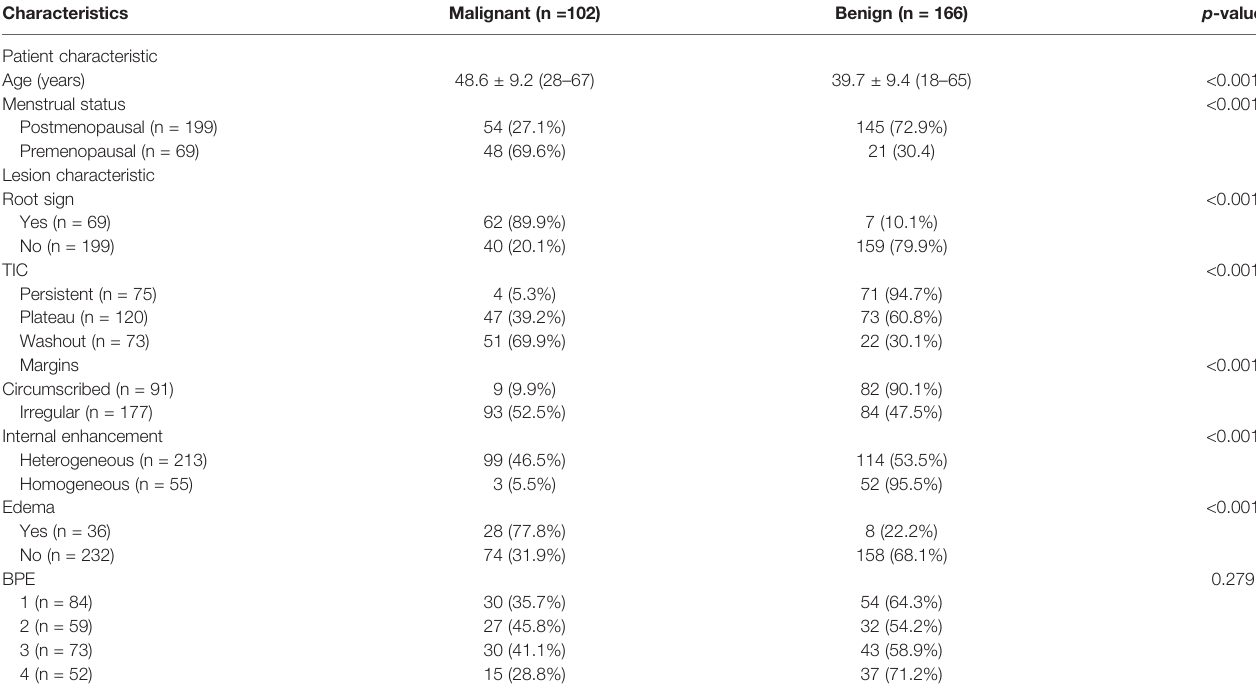
TABLE 2 | Characteristics of patients and lesions.